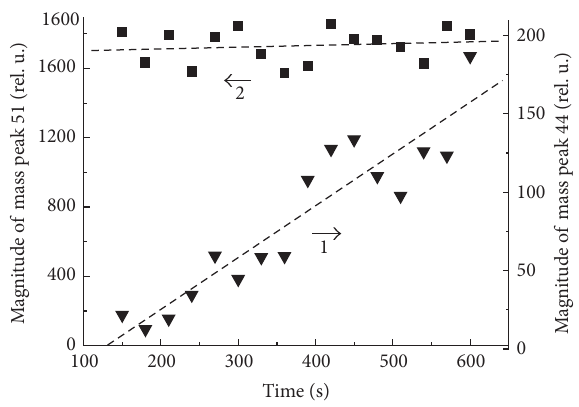
F 6: e spectral dependencies for titanium dioxide samples: photoadsorption at TiO -II the quantum yields of O (2); the optical density of TiO -II relative to MgO (3). 2